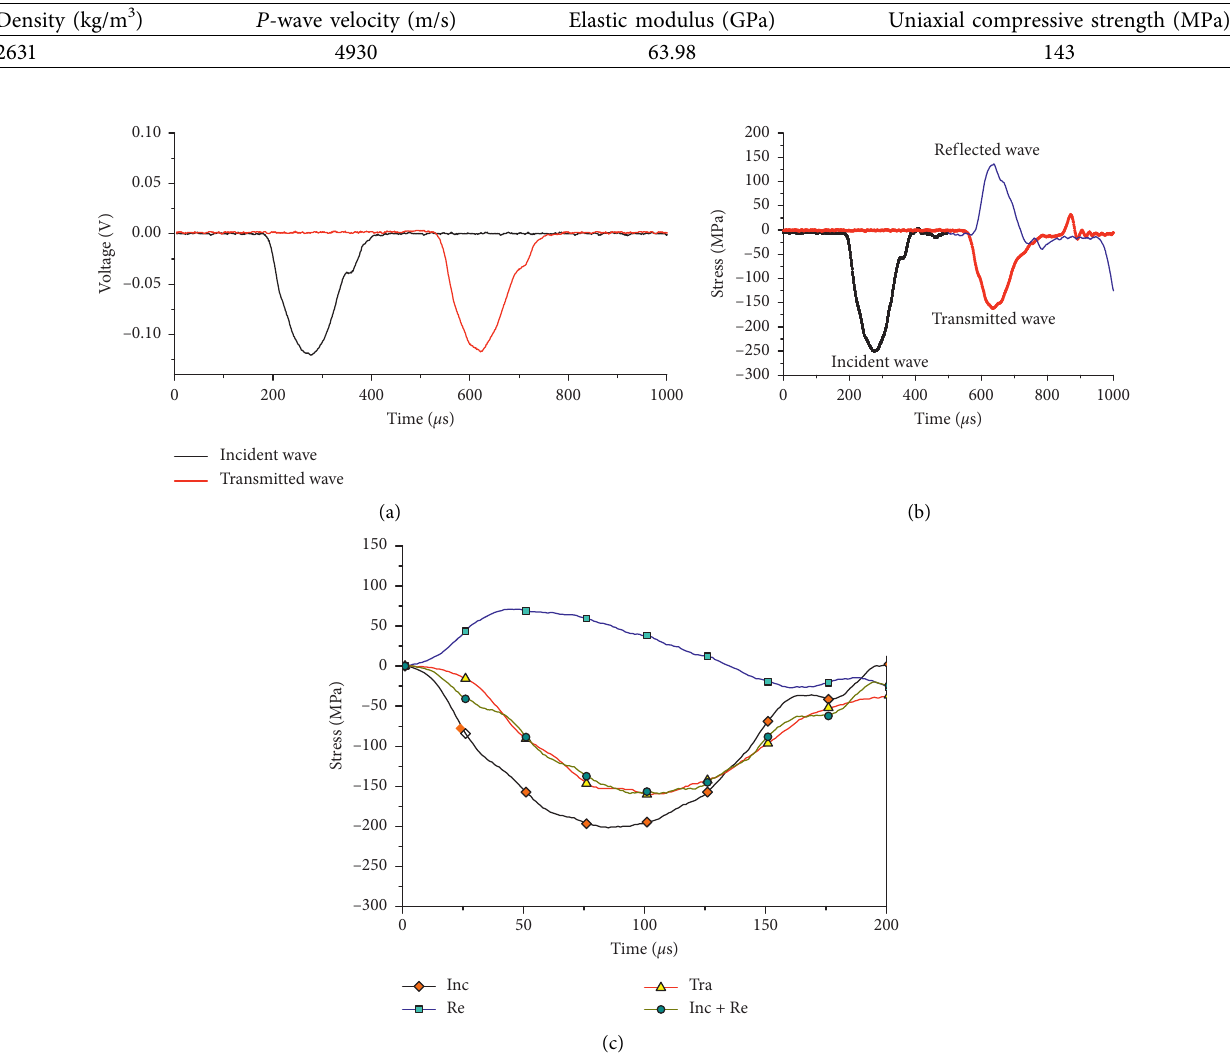
Figure 3: Trial experiment and dynamic stress equilibrium. (a) Signals collected by data acquisition system during trial experiment without specimen. (b) Typical stress wave pattern of a tested rock specimen. (c) Dynamic stress equilibrium (Inc: incident wave, Re: reflected wave, and Tra: transmitted